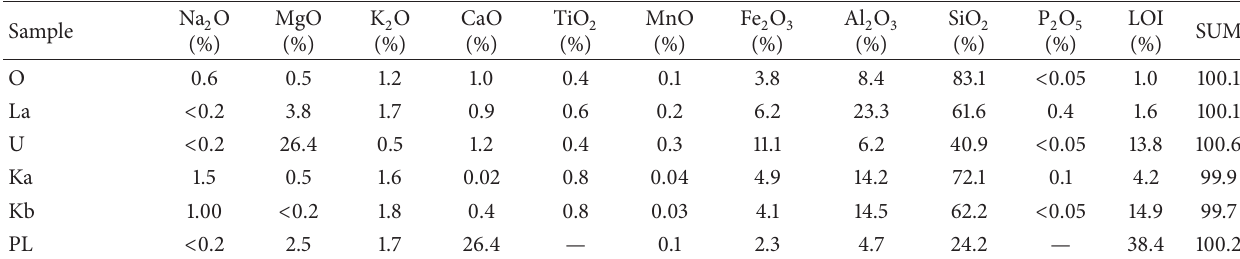
Table 2: Mean concentrations for major elements content in soils (energy dispersive-XRF); measurement relative standard error was less than 5%.